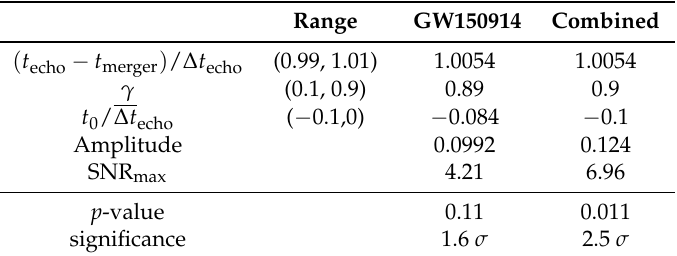
Table 6. Comparing the expected theoretical values of echo time delays ∆ t echo ’s of each merger event (Equation (144)), to their best combined fit within the 1 σ credible region, and the contribution of each event to the combined SNR for the echoes (Equation (148)) [18]. GW150914 GW151012 GW151226